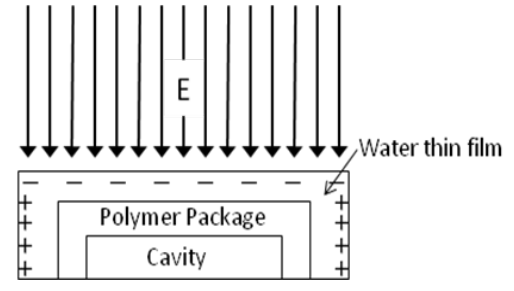
Figure 3. Sketch of electric field